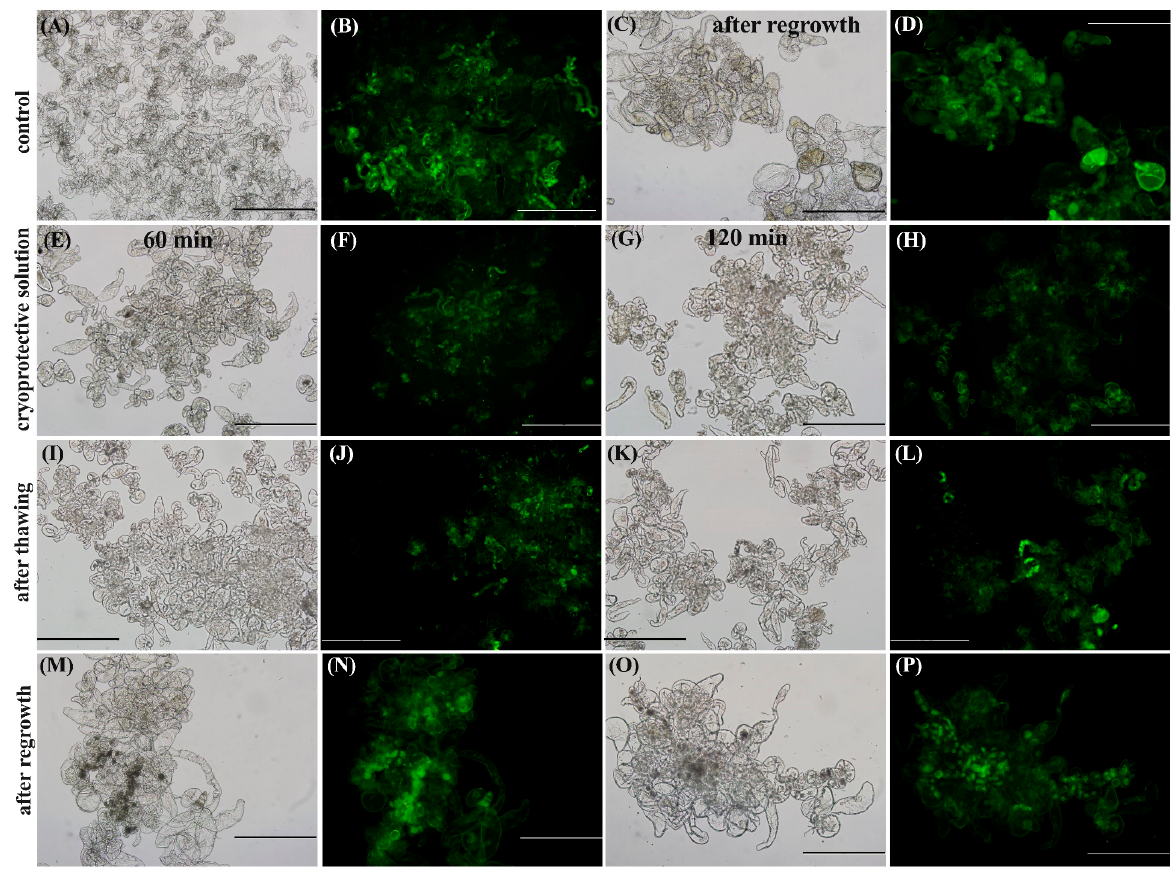
Figure 5. FDA staining of G. chacoensis embryogenic cultures showing the cell viability of the control ( A , B ), control after regrowth ( C , D ), after the use of cryoprotective solution ( E – H ), after thawing ( I – L ), and after 60 days of regrowth ( M – P ), for 60 min incubation ( E , F , I , J , M , N ), and 120 min incubation ( G , H , K , L , O , P ). Letters A, C, E, G, I, K, M, and O show the bright field, while letters B, D, F, H, J, L, N, and P show the fluorescein diacetate. Bars: 500 μ m.